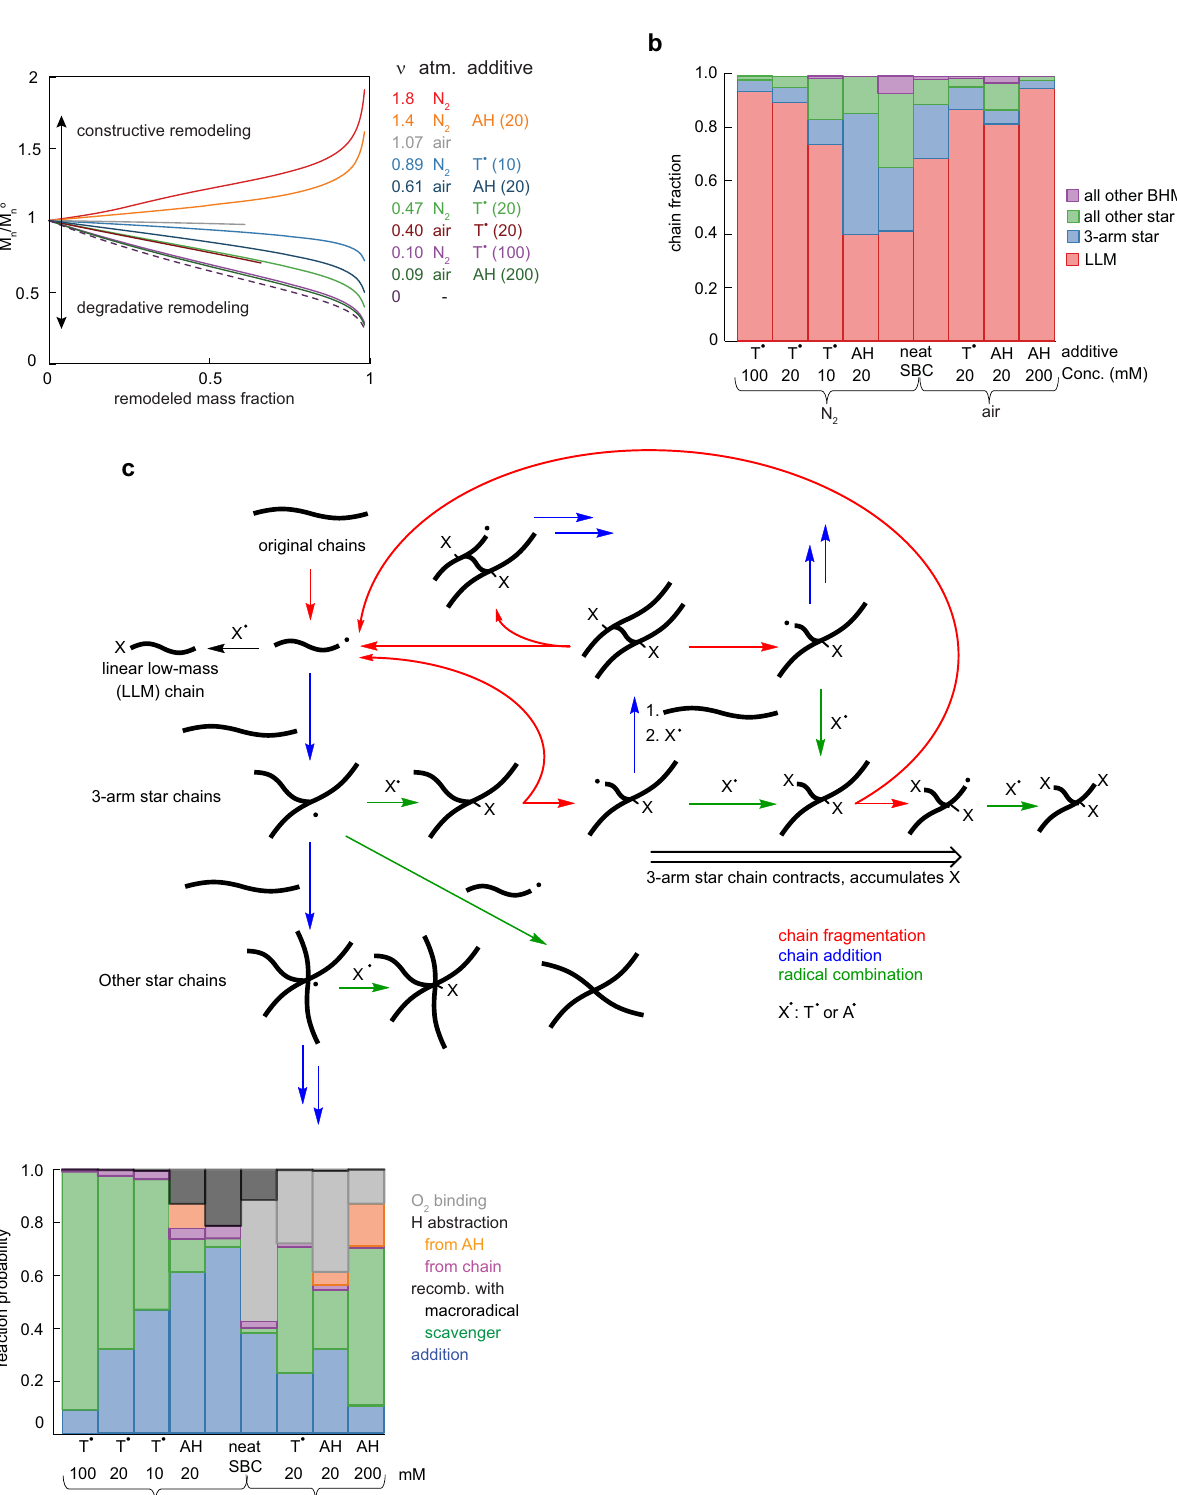
Fig. 5 Key fi ndings and predictions of the mechanism. a The molar mass of the average chain relative to that of the starting material, M n / M n o as a function of the mass fraction of remodeled material; ν is the number of backbone bonds formed per fracture. b The composition of the product chains at different polymer compositions. c The primary reactions responsible for repeated formation and fracture of branched chains in the mechanically loaded polymer. H-atom transfers are omitted. Chain fragmentation always yields two macroradicals; when they have the same microstructure, only one chain is shown for simplicity. d Reaction selectivities of aR (cid:129) in polymers of different composition. Relatively slow diffusion in the solid allows additions (blue) to compete with barrierless recombinations with T (cid:129) , A (cid:129) or O 2 (green and grey). The equivalent data for sR (cid:129) and ROO (cid:129) is plotted in Supplementary Fig.